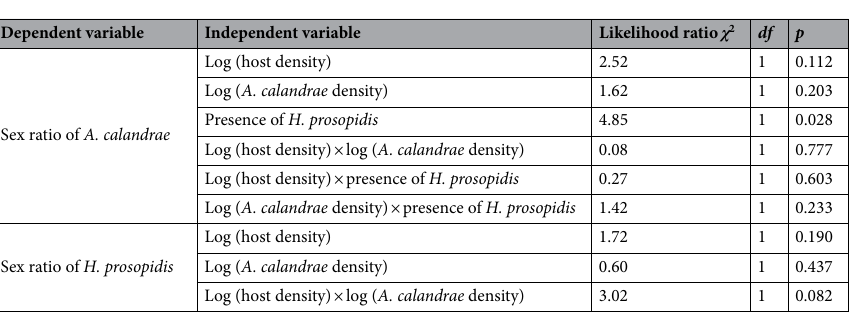
Table 2. Effect tests for the logistic regression model of offspring sex ratio (proportion female) as a function of host density, the density of the native parasitoid Anisopteromalus calandrae , the presence/absence of the nonnative parasitoid Heterospilus prosopidis , and all two-way interactions.